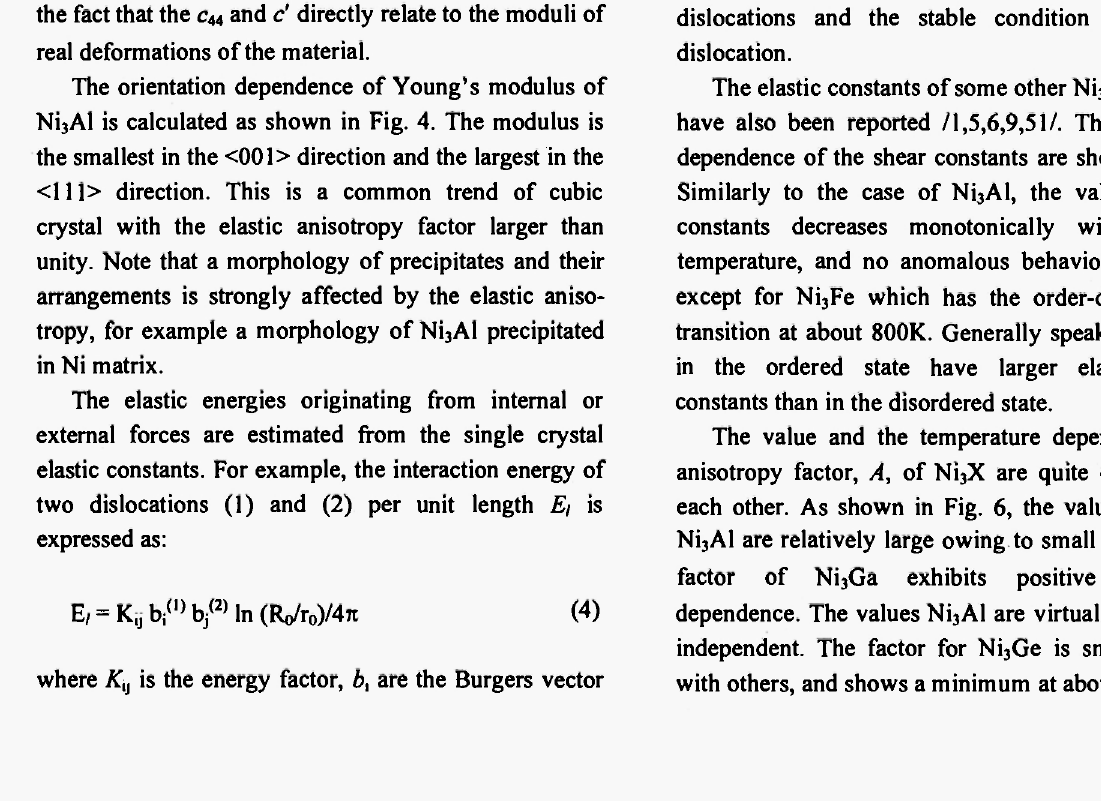
Fig. 4: Orientation dependence of the Young's modulus of Ni 3 Al single